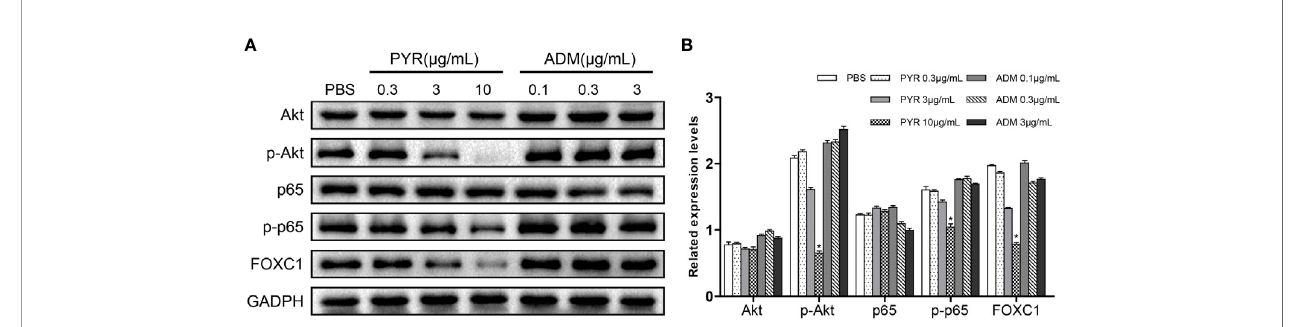
FIGURE 7 | Molecular mechanism studies in breast cancer cells after treatment of PBS, PYR, ADM, or a combined treatment. SK-BR-3 cells were treated with PBS, different concentrations of PYR (0.3, 3, 10 m g/ml), ADM (0.1, 0.3, 3 m g/ml) for 24 h, respectively. Nuclear and cytosolic protein extracts were subjected to Western blot analysis. (A) The results of Western blot for Akt, p-Akt, p65, p-p65, and FOXC1 in the nuclear fractions and cytosolic extracts, respectively. GADPH served as the loading control. (B) Quantitative analysis of the Western blotting results. Data represent the mean ± S.D. of three independent experiments. *p<0.05 with the PBS group.